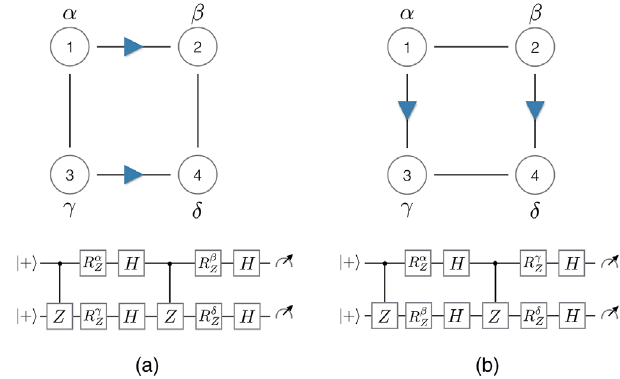
state.FIG. 4. A 2 × 2 cluster state with measurement